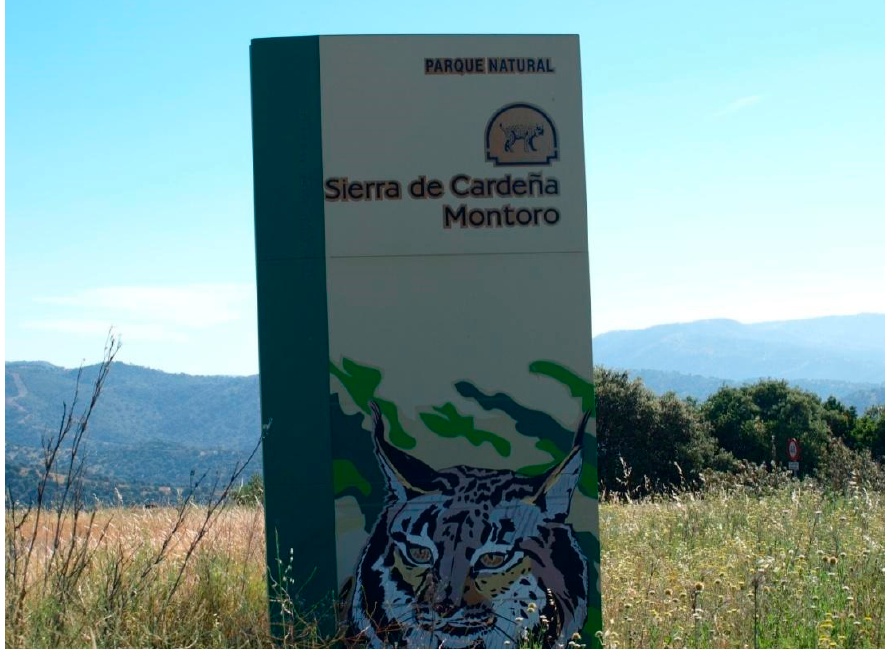
Figure 2. Informative panel at Sierra de Cardeña y Montoro Natural Park (Cordoba, Spain). (Photography: José Luis Serrano-Montes).